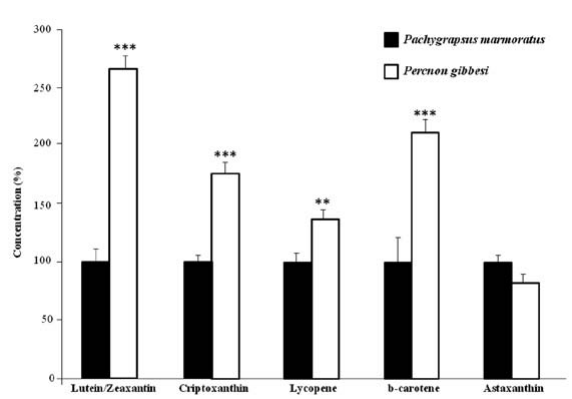
Fig. 1. – Carotenoid concentrations (% in comparison with Pachy­ grapsus marmoratus ) determined in carapaces of the native and the invasive Percnon gibbesi in Portals Vells (Mallorca, Balearic Is- lands, western Mediterranean in July 2009 at <1 m depth. ** p<0.01 and *** p<0.001 (one-way